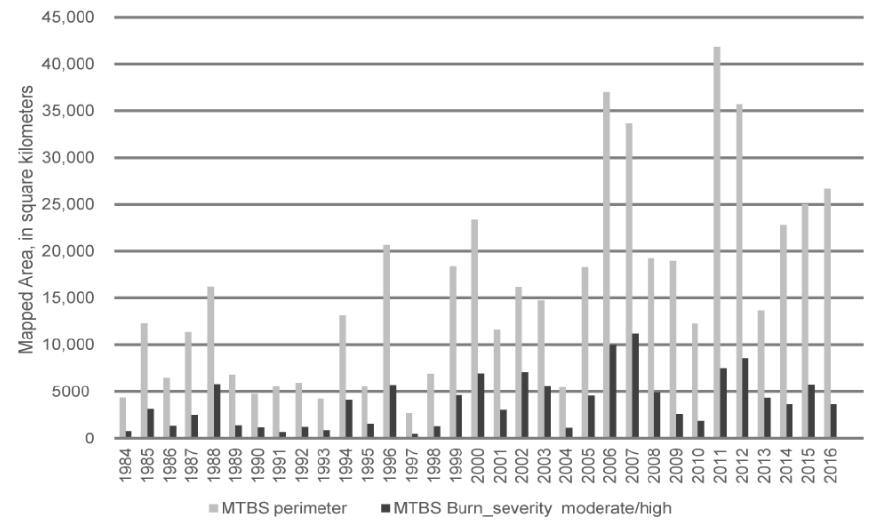
Figure 4. Mapped area of major fires and burn severity from Monitoring Trends in Burn Severity map data [46] in the CONUS, 1984 – 2016.